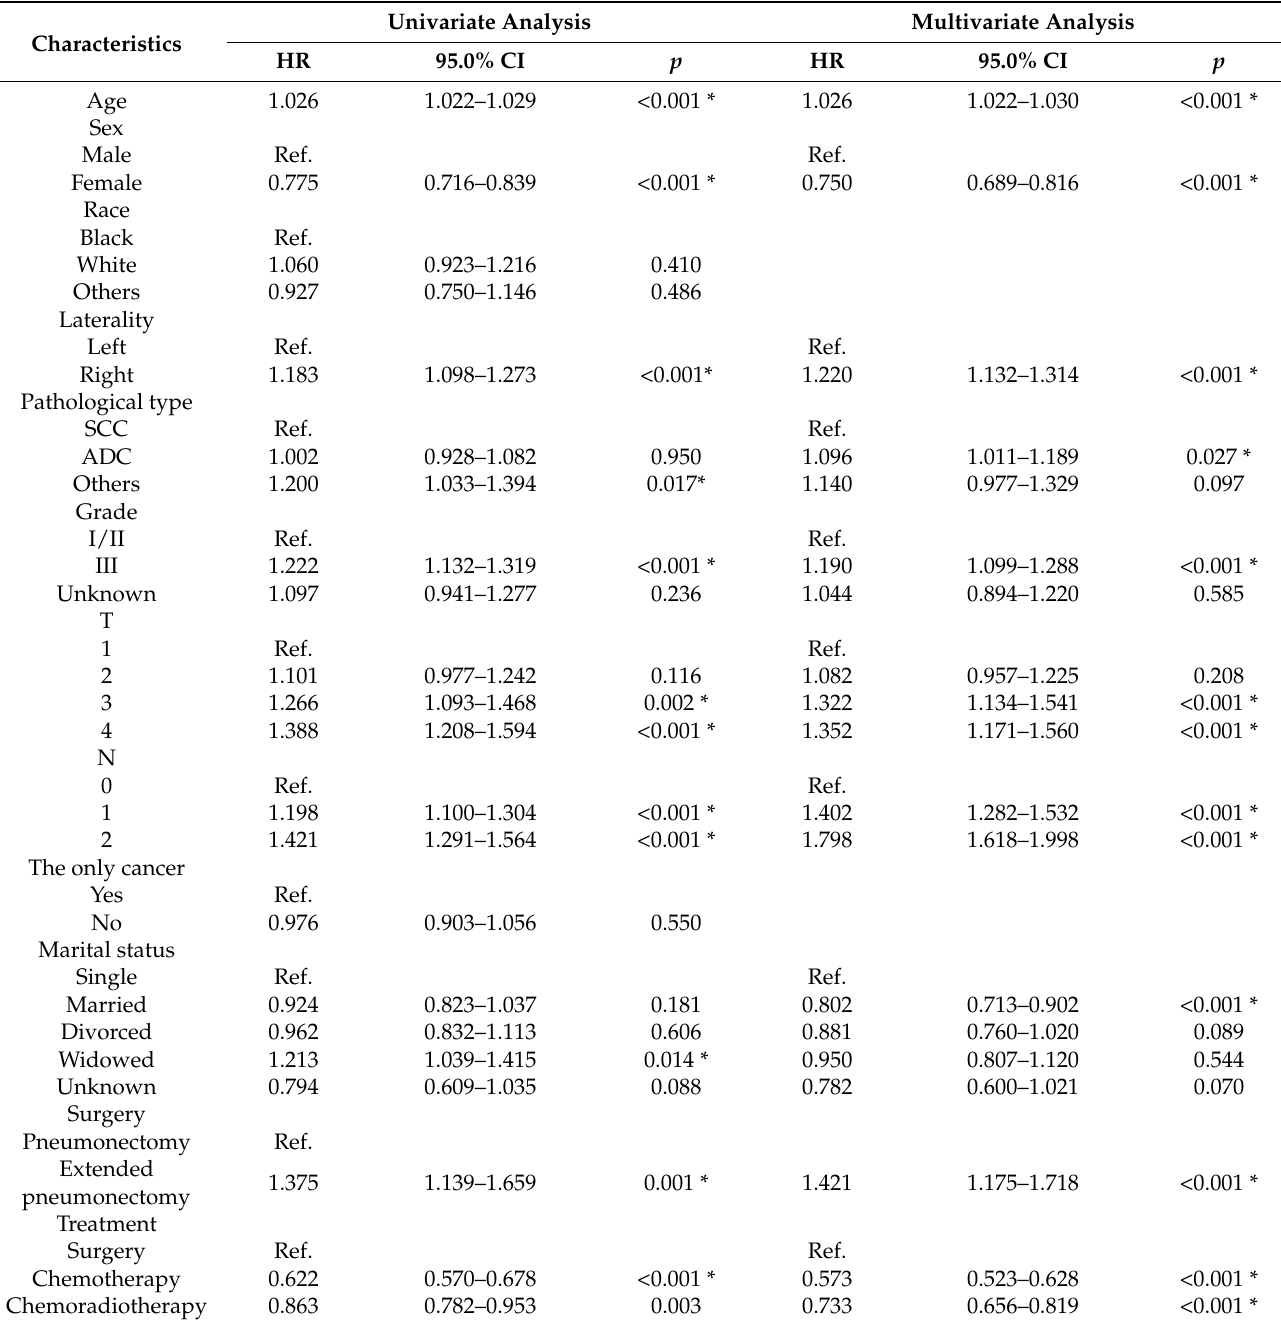
Abbreviations: HR, Hazard Ratio; CI, confidence interval; Ref., Reference. Note: * Indicates significant difference at p <